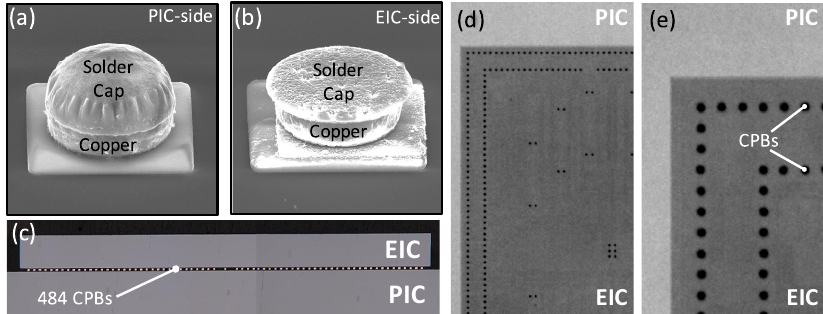
Figure 13. Analysis of the copper ‐ pillar ‐ bumps (CPBs) for vertical integration; ( a , b ) SEM images of the ‘top’ and ‘bottom’ CPBs that form the vertical interconnect between the PIC and EIC before solder ‐ reflow bonding. The asymmetric pairing of the CPBs helps to reduce slippage during the flip ‐ chip alignment; ( c ) Side ‐ view image of the PIC + EIC assembly after a ‘grind and polish’ has been used to expose approximately 70 CPBs; ( d , e ) X ‐ ray microscope images of the PIC+EIC assembly, allowing the operator to ‘see through’ the EIC, and identify the position of the CPBs. This diagnostic allows the operator to non ‐ destructively identify missing or grossly malformed CPBs.